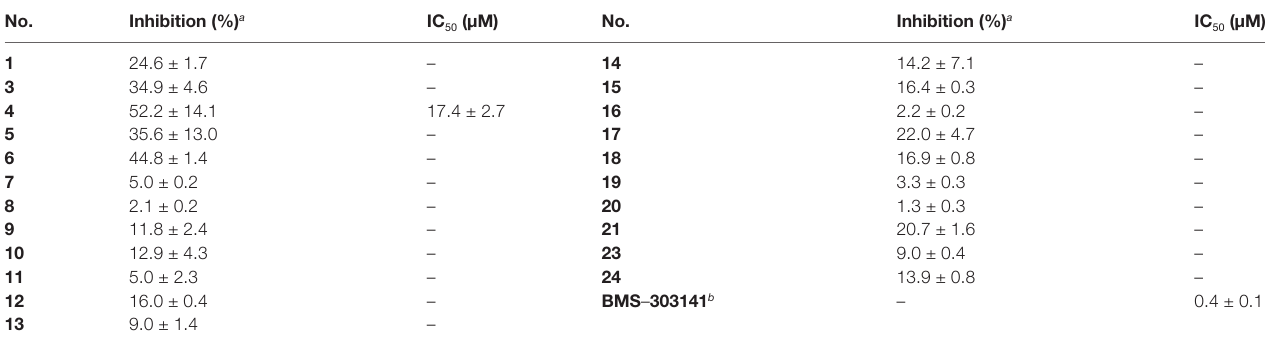
TABLE 2 | Inhibitory activities of compounds 1, 3-21, 23, and 24 against